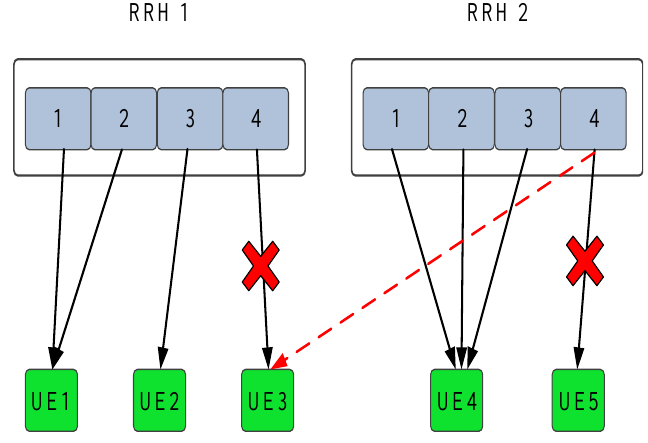
Figure 6. Diagram of an association